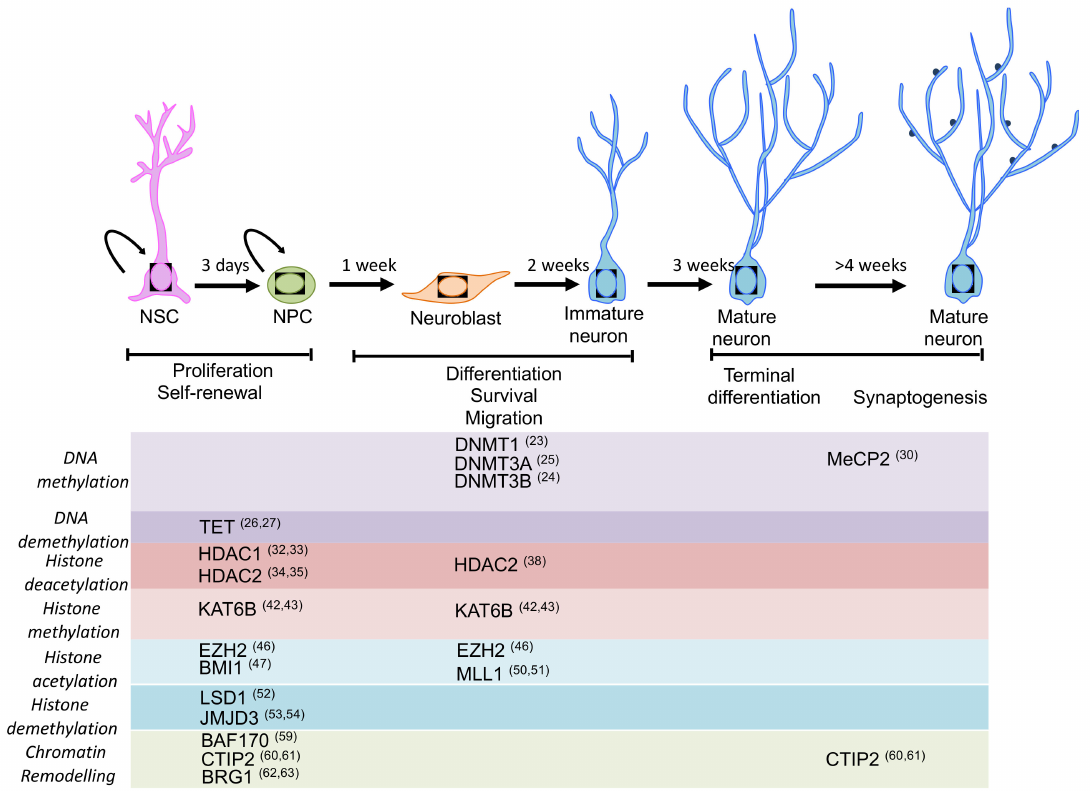
Figure 1. Schematic representation of the main stages of neurogenesis and the epigenetic machinery involved in the regulation of neurogenesis. Expression pattern of the main epigenetic regulators for which a function in adult neurogenesis has been described or proposed. Most of the regulators play an important role in self-renewal, proliferation and fate specification during neurogenesis (please see main text for